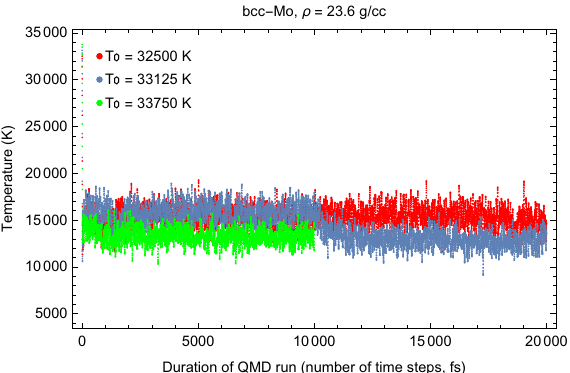
Figure 1. Time evolution of temperature for body-centred cubic (bcc) Mo in three QMD runs with initial temperatures (T 0 s) separated by 625 K: The middle run is the melting run, during which T decreases from ∼ 17,000 K for the superheated state to ∼ 12,800 K for the liquid at the corresponding melting